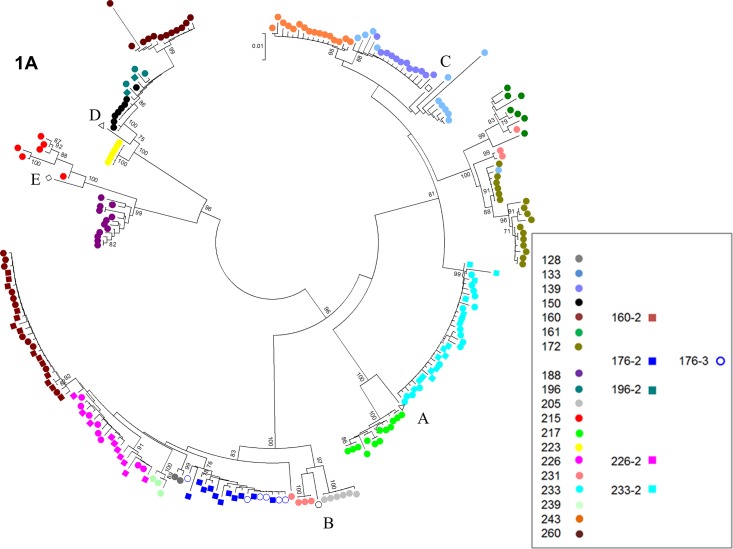
Neighbor-joining phylogenetic reconstruction of the HBV pre-S/S (A, N = 20), Pre-C/C (B, N = 11) and full genome (C, N = 3) using the bootstrap method.Clustering is prominent between individual cases, indicating a greater degree of variation between individuals, than amongst each of their viral quasispecies. Bootstrap values greater than 70 were considered significant. Case #146 was excluded from analysis as only the pre-S1 region was sequenced.